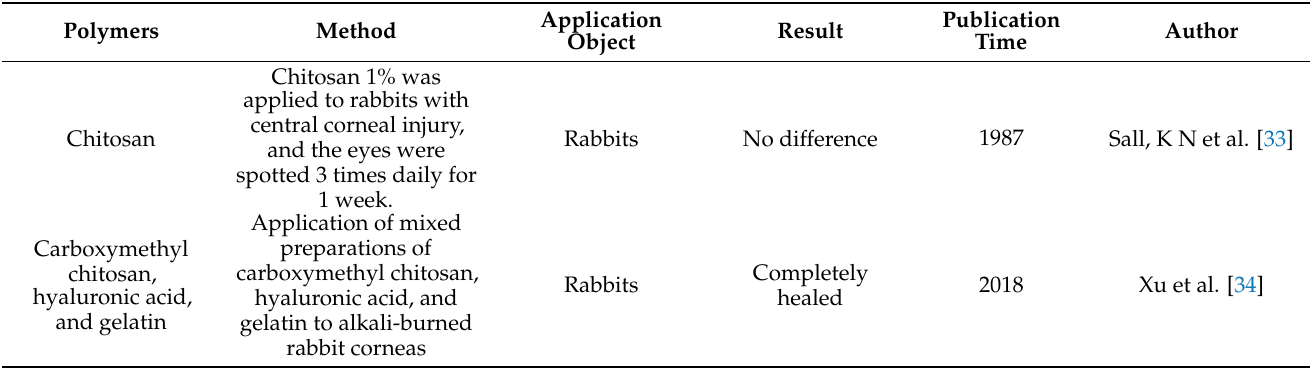
Table 3. Application of various polymers in